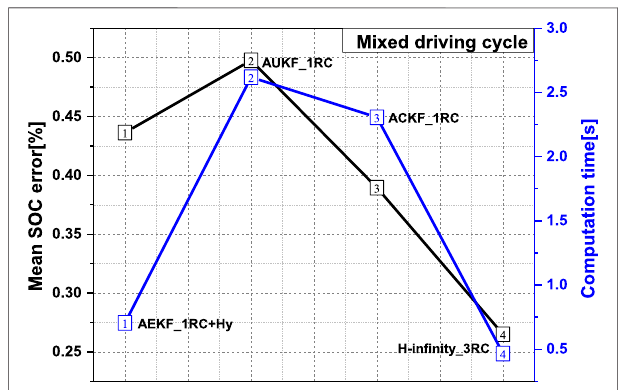
FIGURE 9 | Comparison results of the four estimators with white noise.